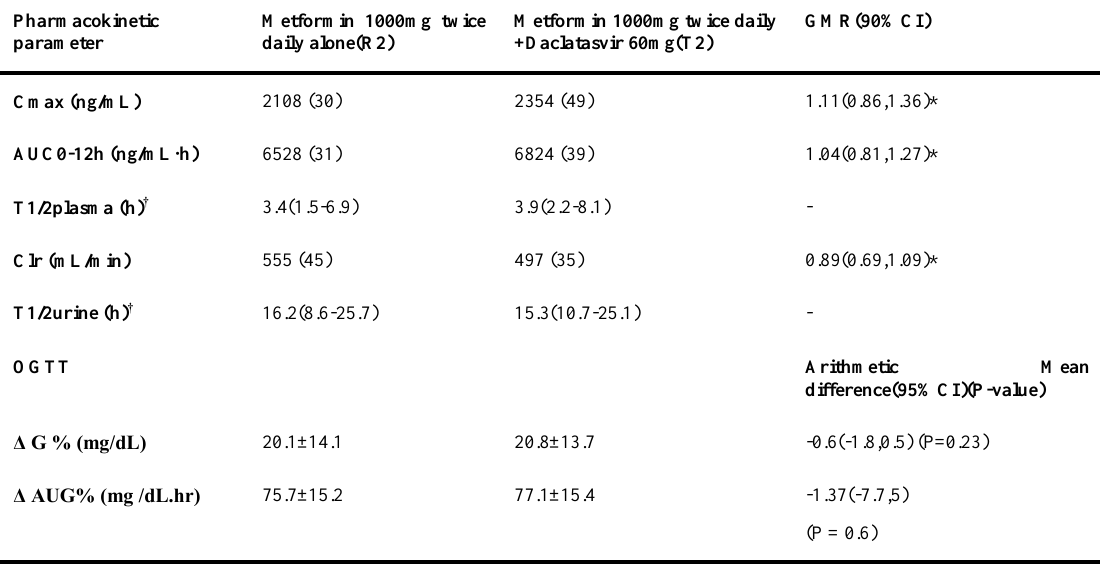
Table 3. Pharmacokinetics and OGTT parameters of metformin 1000 mg either alone or with daclatasvir 60 mg Pharmacokinetic